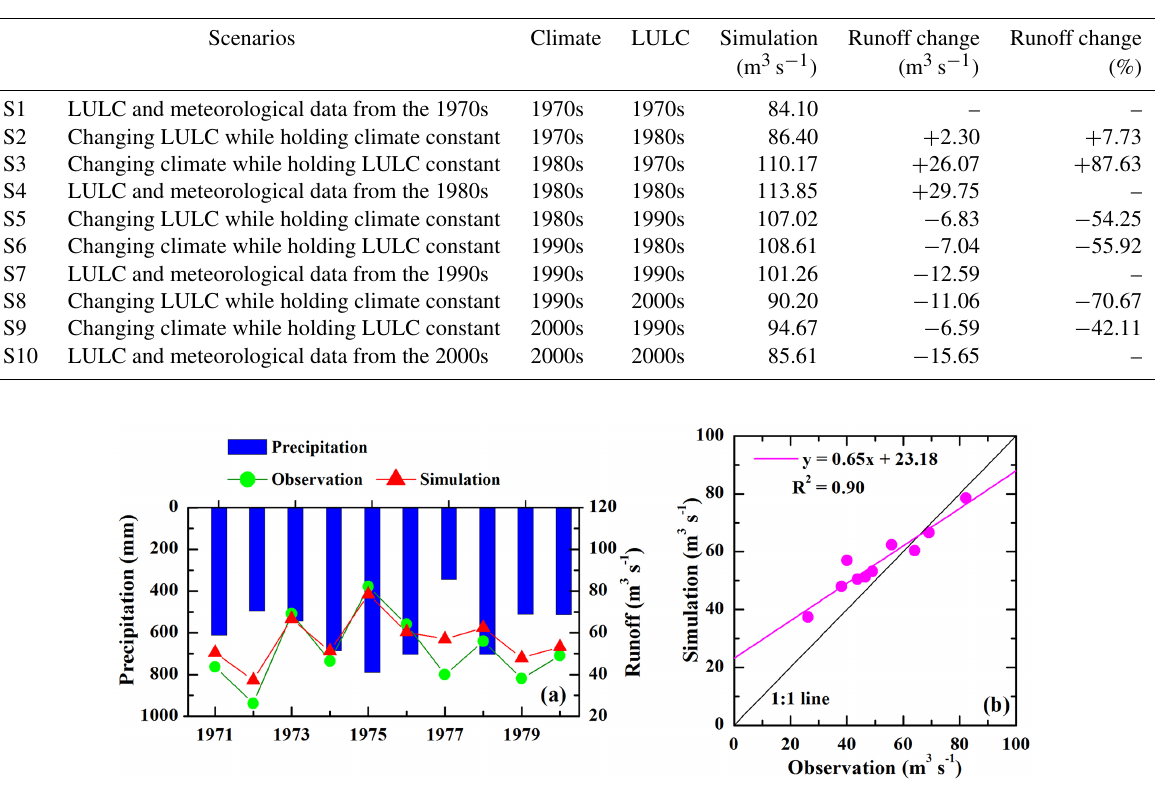
Figure 4. Comparison of observed and simulated runoff at the yearly scale in the Jinghe River basin during the calibration period from 1971 to 1980. Panel (b) is redrawn from Qiu et al. (2011).